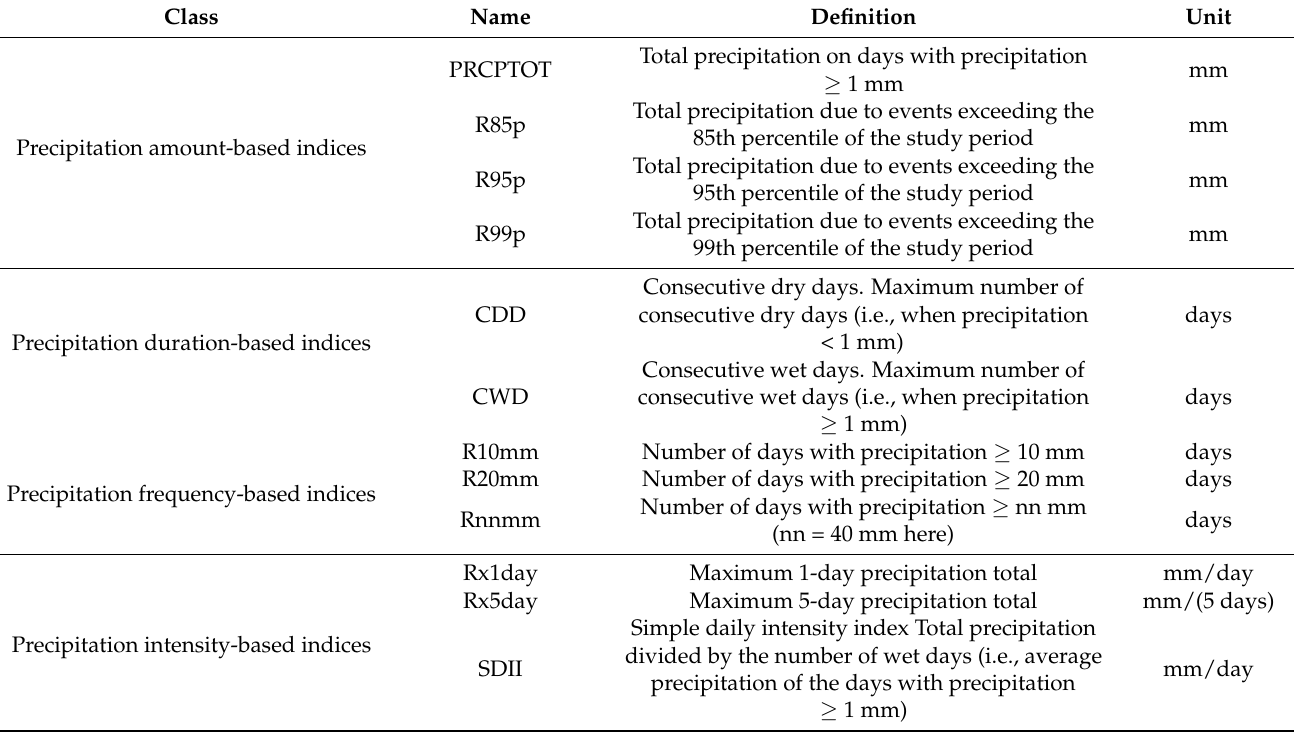
Table 1. Definitions of the selected 12 extreme precipitation